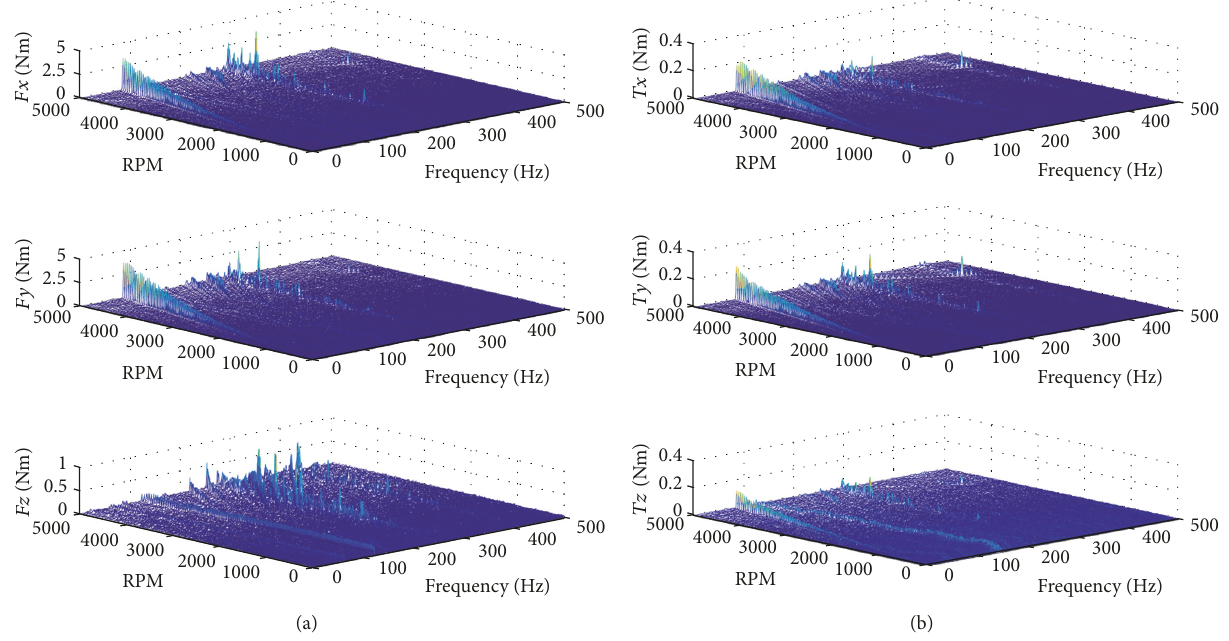
Figure 15: Waterfall plots of disturbance forces and torques for RWA activation without isolation ((a): disturbance forces and (b): disturbance